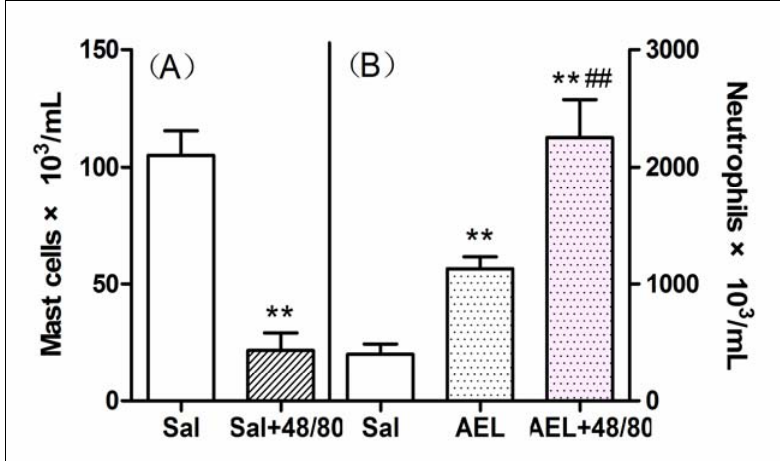
Figure 8. Analysis of the participation of mast cells on the neutrophil migration induced by AEL (200 μ g/mL/cavity). ( A ) Peritoneal mast cell population in normal (Sal) or pre-treated animals with compound 48/80 (Sal + 48/80) after injection with 1 mL saline; ( B ) Neutrophil migration induced by 1mL of saline (Sal) and AEL (200 μ g/cavity in 1 mL of saline) in normal (AEL) or compound 48/80 pre-treated animals (AEL + 48/80). Results are mean ± S.D. (n = 6). ** P < 0.01 compared with saline and ## P < 0.01 compared with